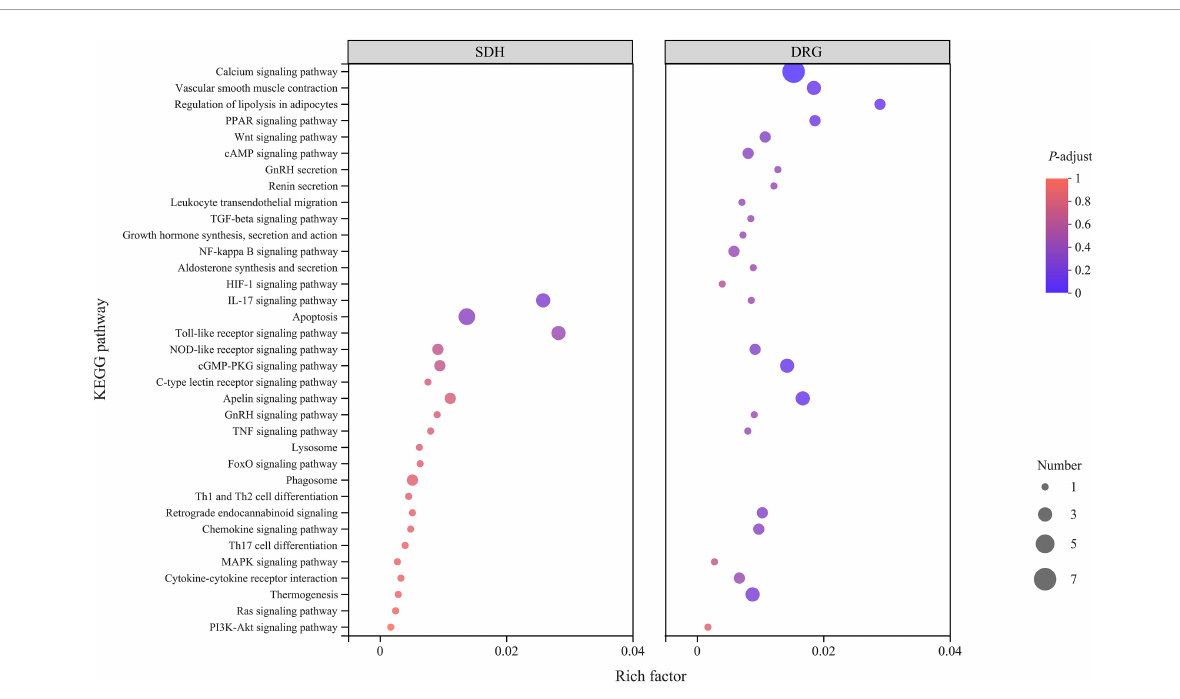
FIGURE6 KEGG analysis results of DRG samples. SDH on the left and DRG on the right, the abscissa is the KEGG pathway, and the ordinate is the rich factor. The higher the rich factor, the greater the degree of enrichment, and the size of the dots indicates the number of genes in the pathway, while the color of the dots corresponds to the different P -adjust